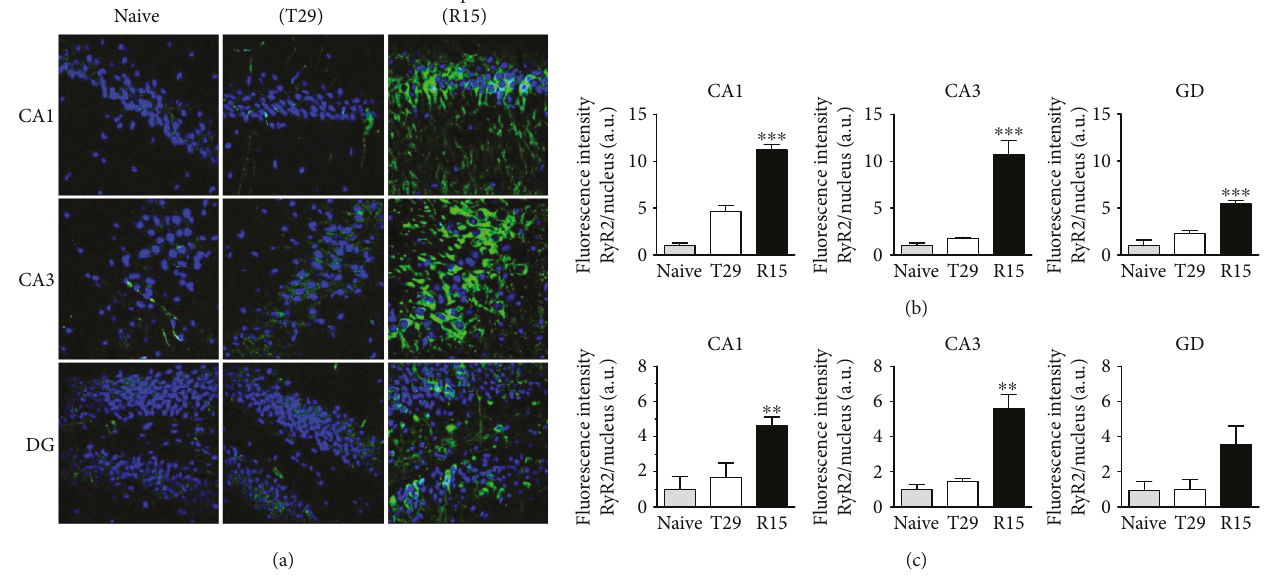
Figure 4: Memory extinction promotes RyR2 upregulation in situ. (a) Representative confocal images of RyR2 immuno fl uorescence (green) and Hoechst nucleus stain (blue) obtained from CA1, CA3, and DG region of the hippocampus. Samples were obtained 29 h after training (T29) or 5 h after the 15 min reexposure session (R15). Samples from naïve rats were used as control. Scale bar: 20 μ m. (b) Bar graphs showing the quanti fi cation of RyR2 immuno fl uorescence pixels normalized by nuclear stain present in regions enriched in nuclei in CA1, CA3, and DG. (c) Bar graphs showing the quanti fi cation of RyR2 immuno fl uorescence pixels, normalized by the nuclear stain present in the entire images of CA1, CA3, and DG. Values represent mean ± SE; N = 3 for samples from the control and T29 groups; N = 4 for the R15 group. Statistical analysis was done with one-way ANOVA (CA1 p = 0 0001 , CA3 p = 0 0008 , and DG p = 0 0009 ) followed by Tukey ’ s multiple comparison post hoc test; ∗∗ p < 0 01 ; ∗∗∗ p < 0 001 with respect to naïve and T29,